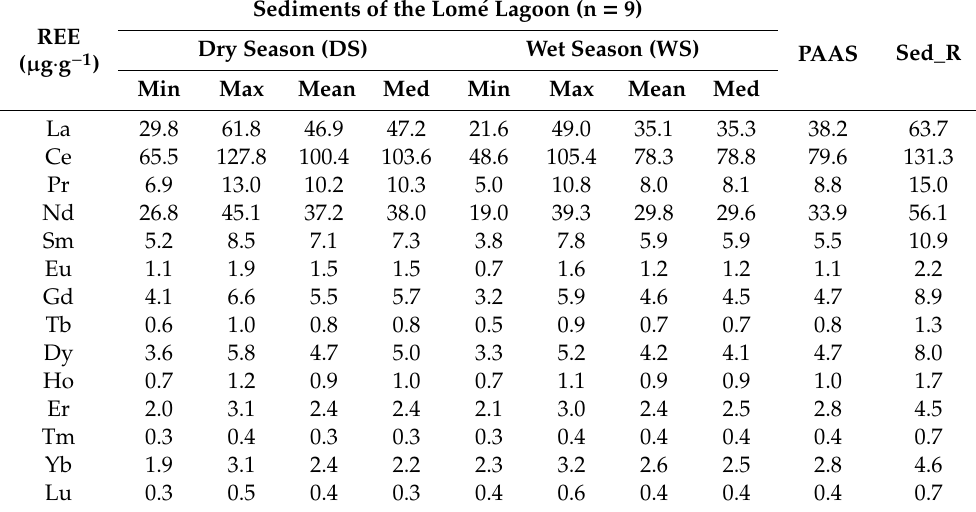
Table 2. Rare earth elements (REE) average concentrations in the fine sediments ( < 63 µ m) of the Lom é lagoon during the dry and the wet seasons, compared with the contents in PAAS and in the local reference material, Sed_R. See also the concentrations for each site in Table S2 (Supplementary Materials). Sediments of the Lom é Lagoon (n = REE ( µ g · g − 1 )